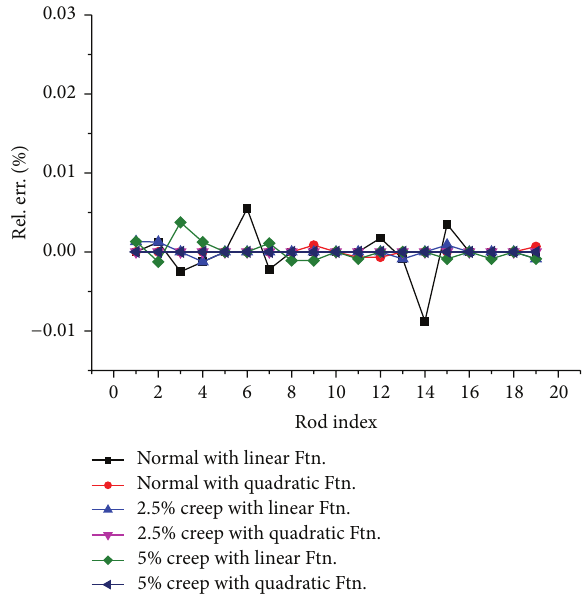
Figure 4: Relative pin power errors with different BCs of the TRIAINA-P1 code.